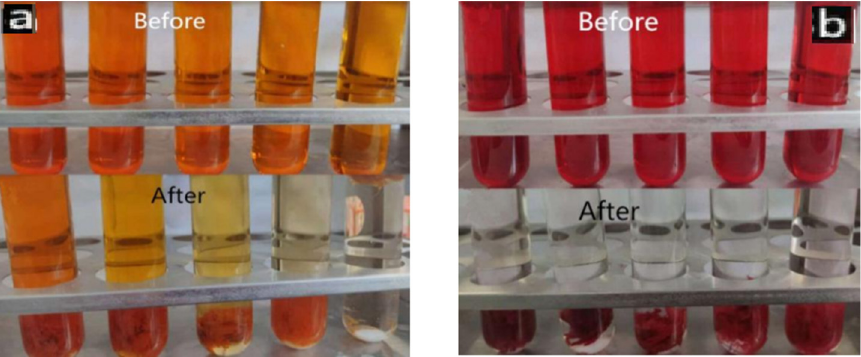
Figure 11. Color changes of MO ( a ) and CR ( b ) dye solutions before and after fiber photocatalysis